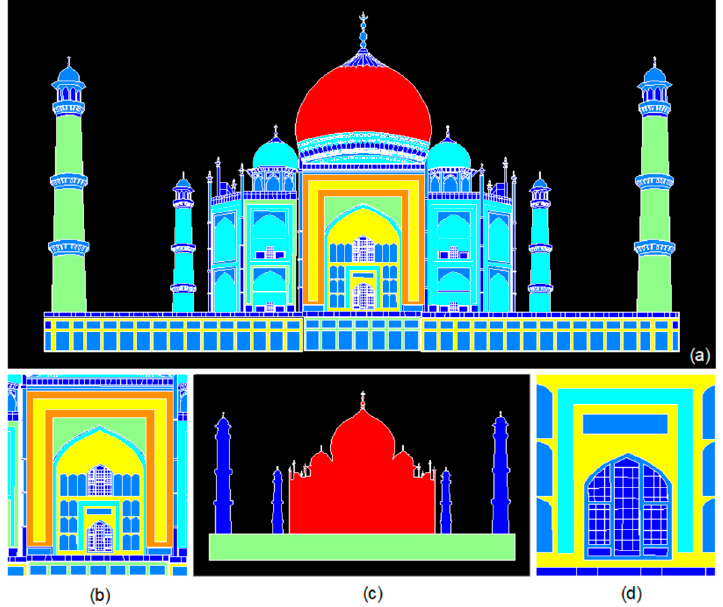
Figure 6. (Color online) The Taj Mahal as a living structure from the façade perspective. Note: There are “far more small centers than larges” in the façade ( a ) with blue being the smallest, red being the largest, and other colors in between the smallest and largest. This is the essence of objective beauty or life. The scaling hierarchy of “far more smalls than larges” recurs six times; for example, ( b ), ( c ), and ( d ) each indicate an occurrence. The notion of “far more smalls than larges” is more powerful than the concept of self-similarity of fractal geometry [23], because the former enables anyone—experts or laymen—to see fractals or living structures not only in nature, but also in what we build and make, such as buildings, art, and designs.